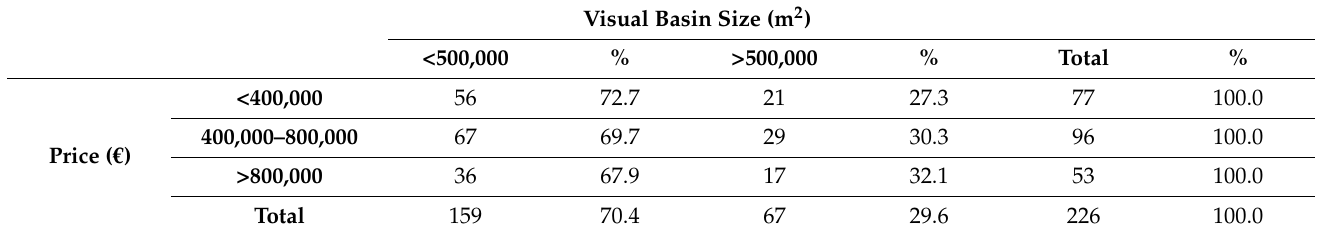
Table 5. Distribution of the dwellings analyzed by price interval and visual basin